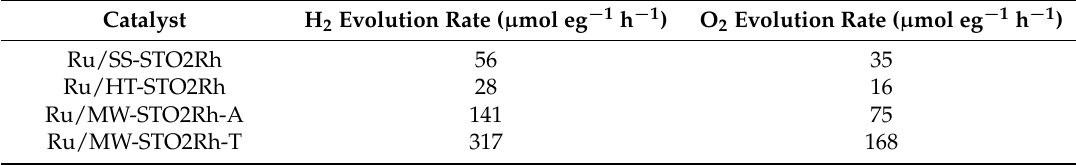
Table 1. Photocatalytic water-splitting activity of Rh-doped SrTiO 3 –BiVO 4 in 0.5 mM CoBpy 2+/3+ solution.